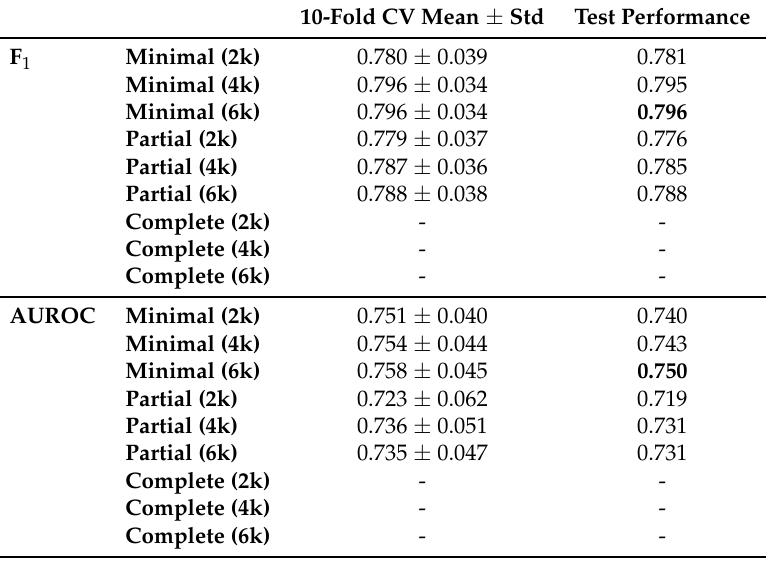
Table 6. Comparison of padding strategies after 2k, 4k, and 6k epochs. The highest test performance is shown in